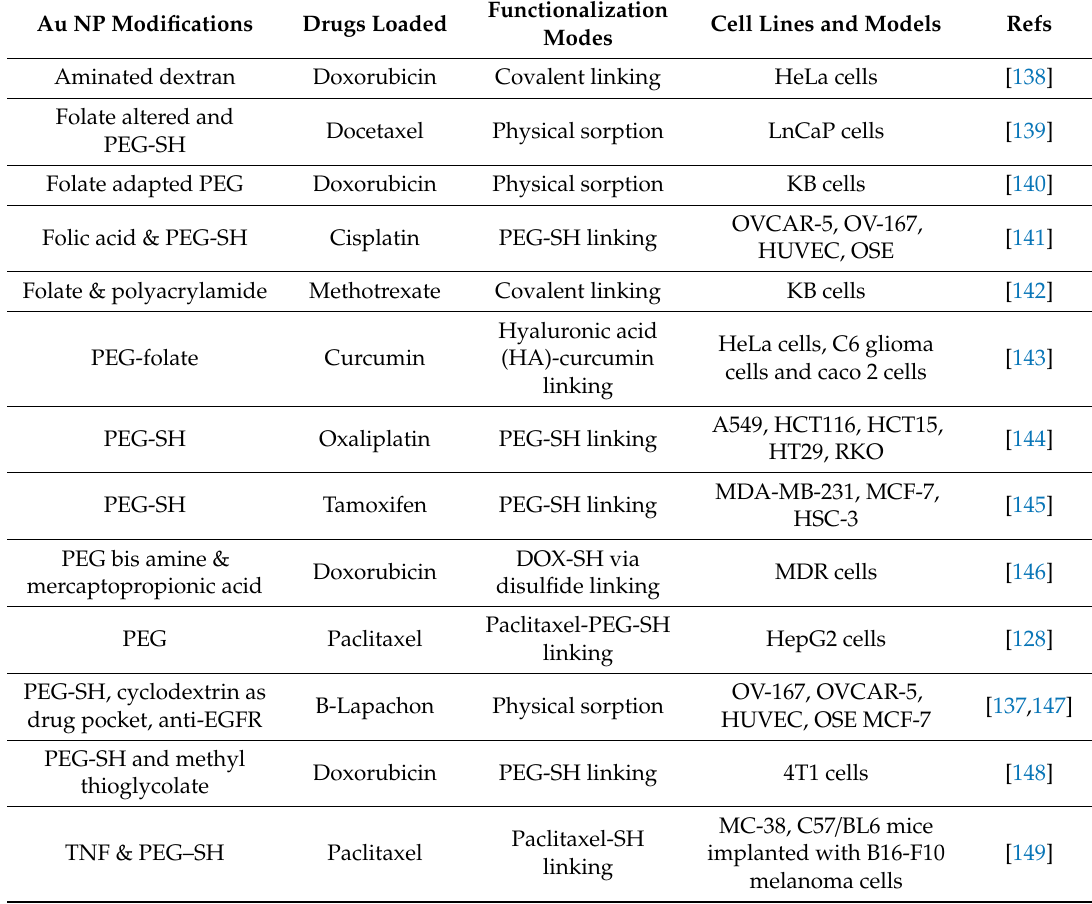
Table 3. The polymeric gold NPs as carriers in drug